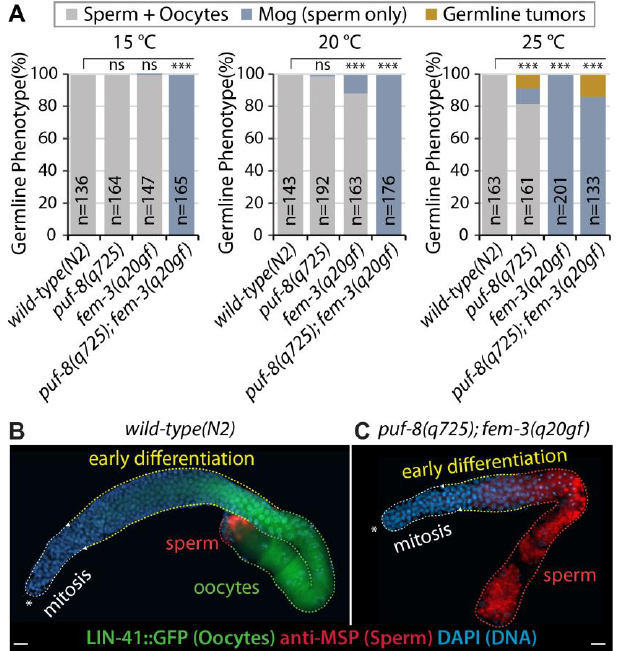
Figure 2. Phenotype analysis of puf-8(q725); fem-3(q20gf) germlines. ( A ) Germline phenotypes were determined by staining dissected gonads with anti-MSP antibodies and DAPI. ( B , C ) Expression of LIN-41::GFP (oocyte marker) and MSP (sperm marker) in wild-type(N2) and puf-8(q725); fem-3(q20gf) mutant germlines. Scale bars are 10 μm . All experiments were performed in triplicate. The statistical significance was assessed by Student’s t -test without corrections for multiple comparisons. ***, p < 0.001; ns, not statistically significant.